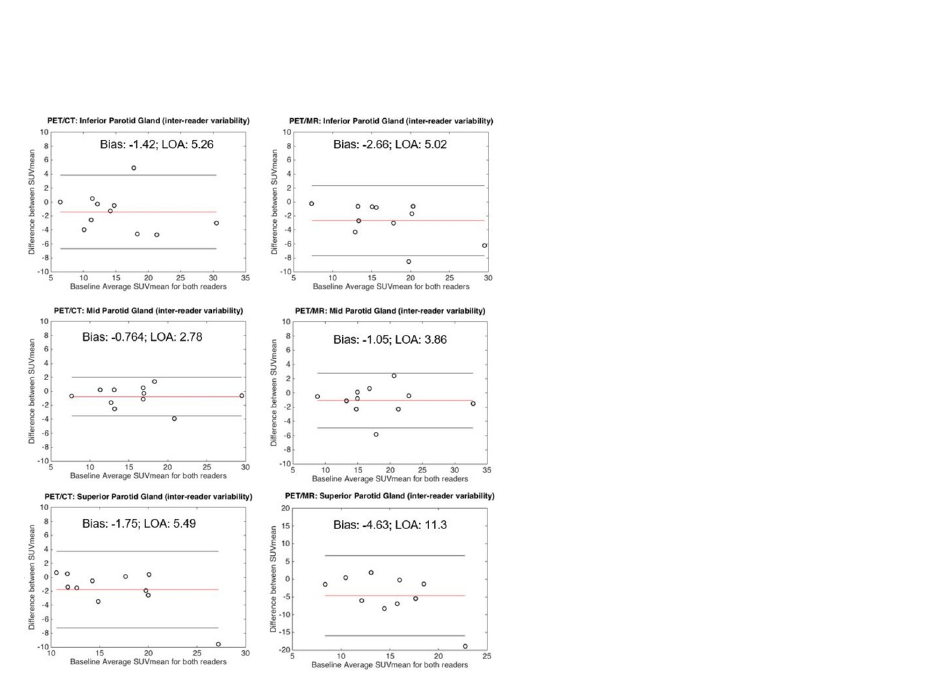
Fig 2. Bland Altman analysis assessing inter-reader variability for 1-cm parotid regional regions of interest. Greater bias and limits of agreement were seen for the 1-cm parotid circular ROIs in the inferior (top), mid (middle), or superior (bottom) parotid gland for both wbPET/CT (left column) or wbPET/MR (right column). The calculated bias (red line) as well as the upper and lower limits of agreement (outer black lines) are demarcated on each plot. The bias and limits of agreement are listed in the top-center or bottom-center of each plot.